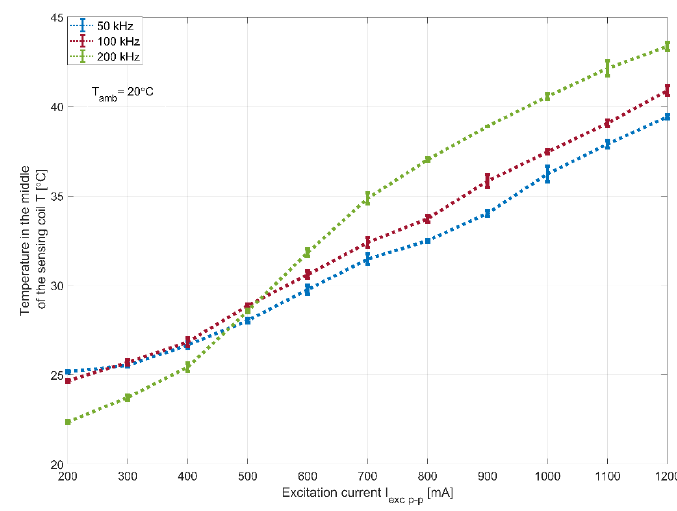
Figure 7. Maximum measured temperature of the sensor as a function of the excitation current.